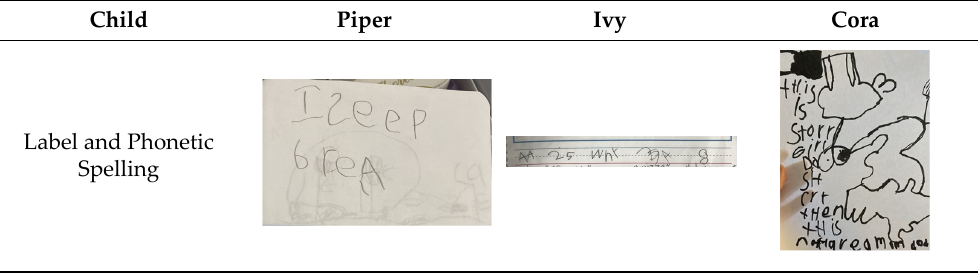
Table 3. The Transitional Stage.